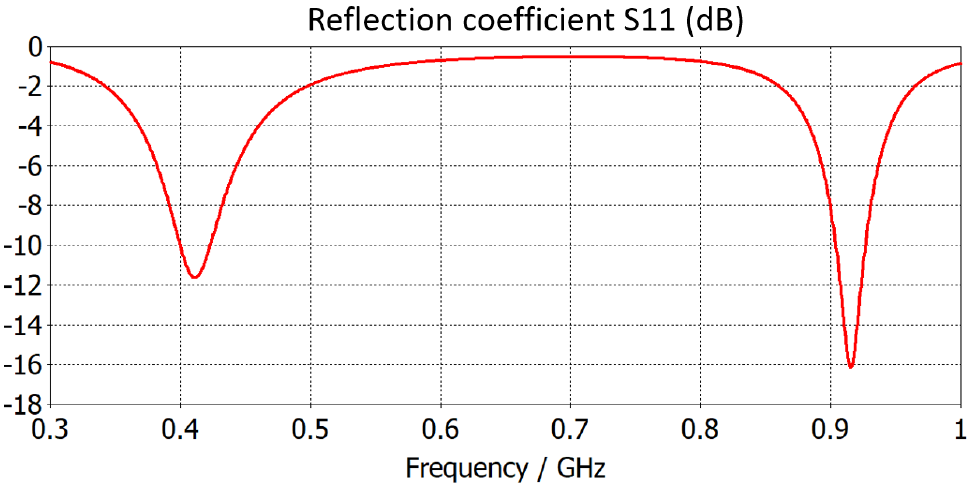
ffi cient of the antenna embedded in the arm Figure 3. Reflection coefficient of the antenna embedded in the arm model. Figure 3. Reflection coe